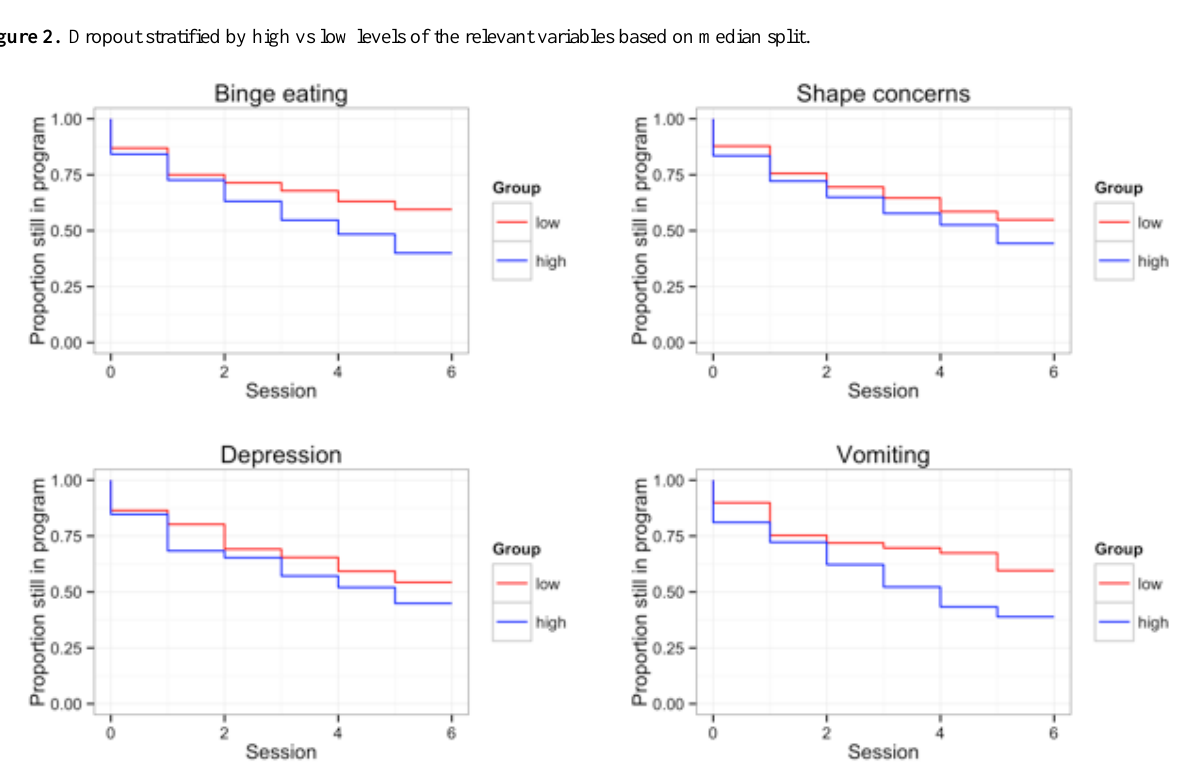
Bootstrapping resultsFull sampleVariable